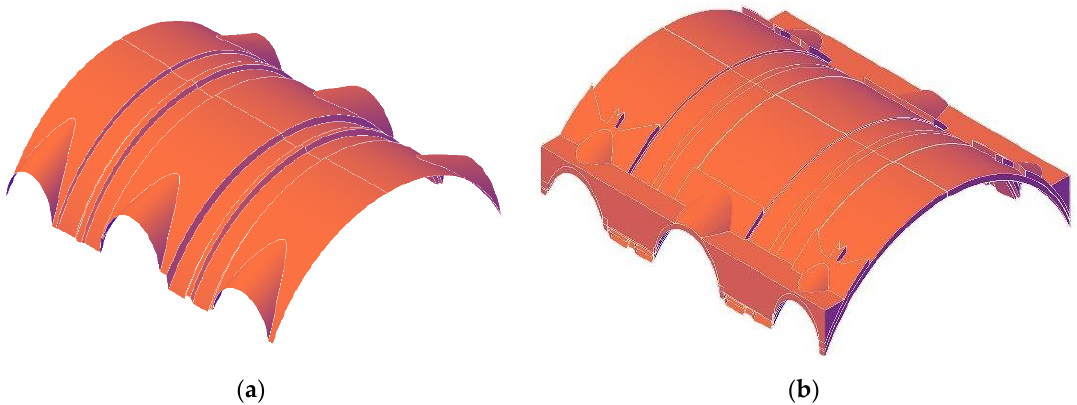
Figure 5. Digital geometric model of St. Marta church vaults for visualization and documentation: ( a ) intrados survey and ( b ) volumetric representation, observed from the extrados.